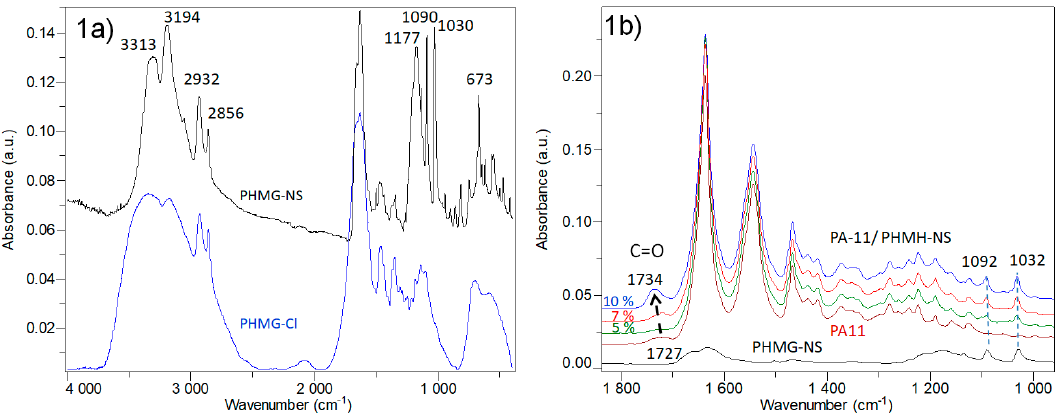
Figure 1. IR spectra: ( a ) PHMG-Cl and PHMG-NS; and ( b ) PHMG-NS, PA-11 and PA-11 / PHMG-NS film with 5%, 7% and 10% of PHMG-NS.